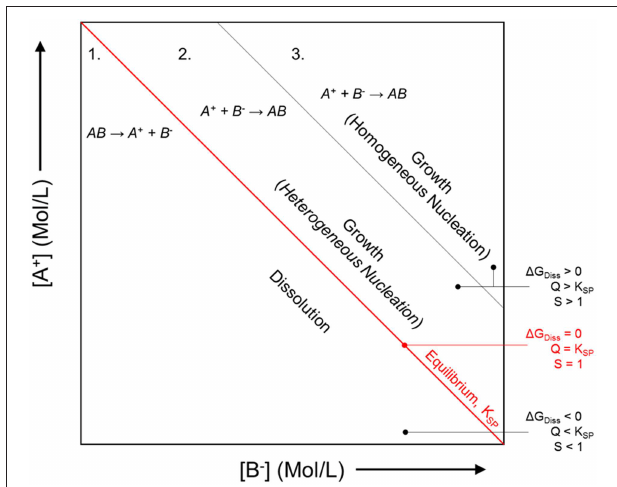
FIGURE 2 | Generalized dependence of the chemical dissolution of a compound on the thermodynamic driving force, or the degree of undersaturation. As the concentration of the product species A + and B − increases, the free energy change associated with the dissolution process, 1 G Diss decreases, proportionate to Q = [A + ][B − ] for any concentration. Conceptual dependence of the crystal growth morphology of precipitating compounds on the thermodynamic driving force, or the degree of supersaturation, S = Q/K SP . The system will tend toward establishing the equilibrium concentration of A + and B − , K SP = [A + ][B − ] at equilibrium. Schematic based on discussions presented by Bastos et al. (2016) and Yan et al. (2010)